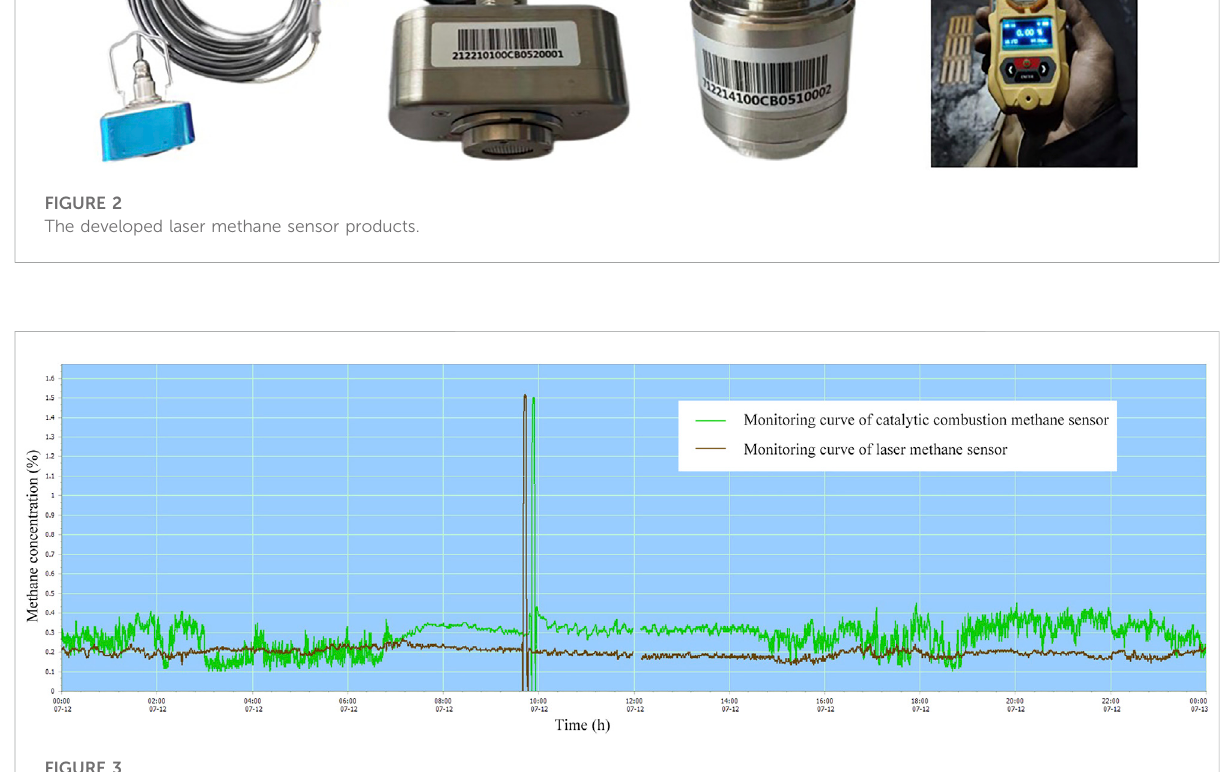
FIGURE 3 The methane monitoring data in 10307 working